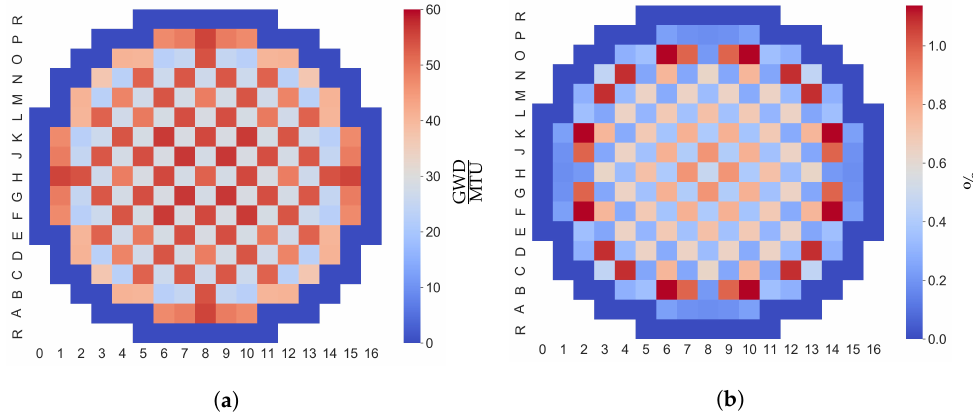
Figure 41. Radial profile of Bu ave